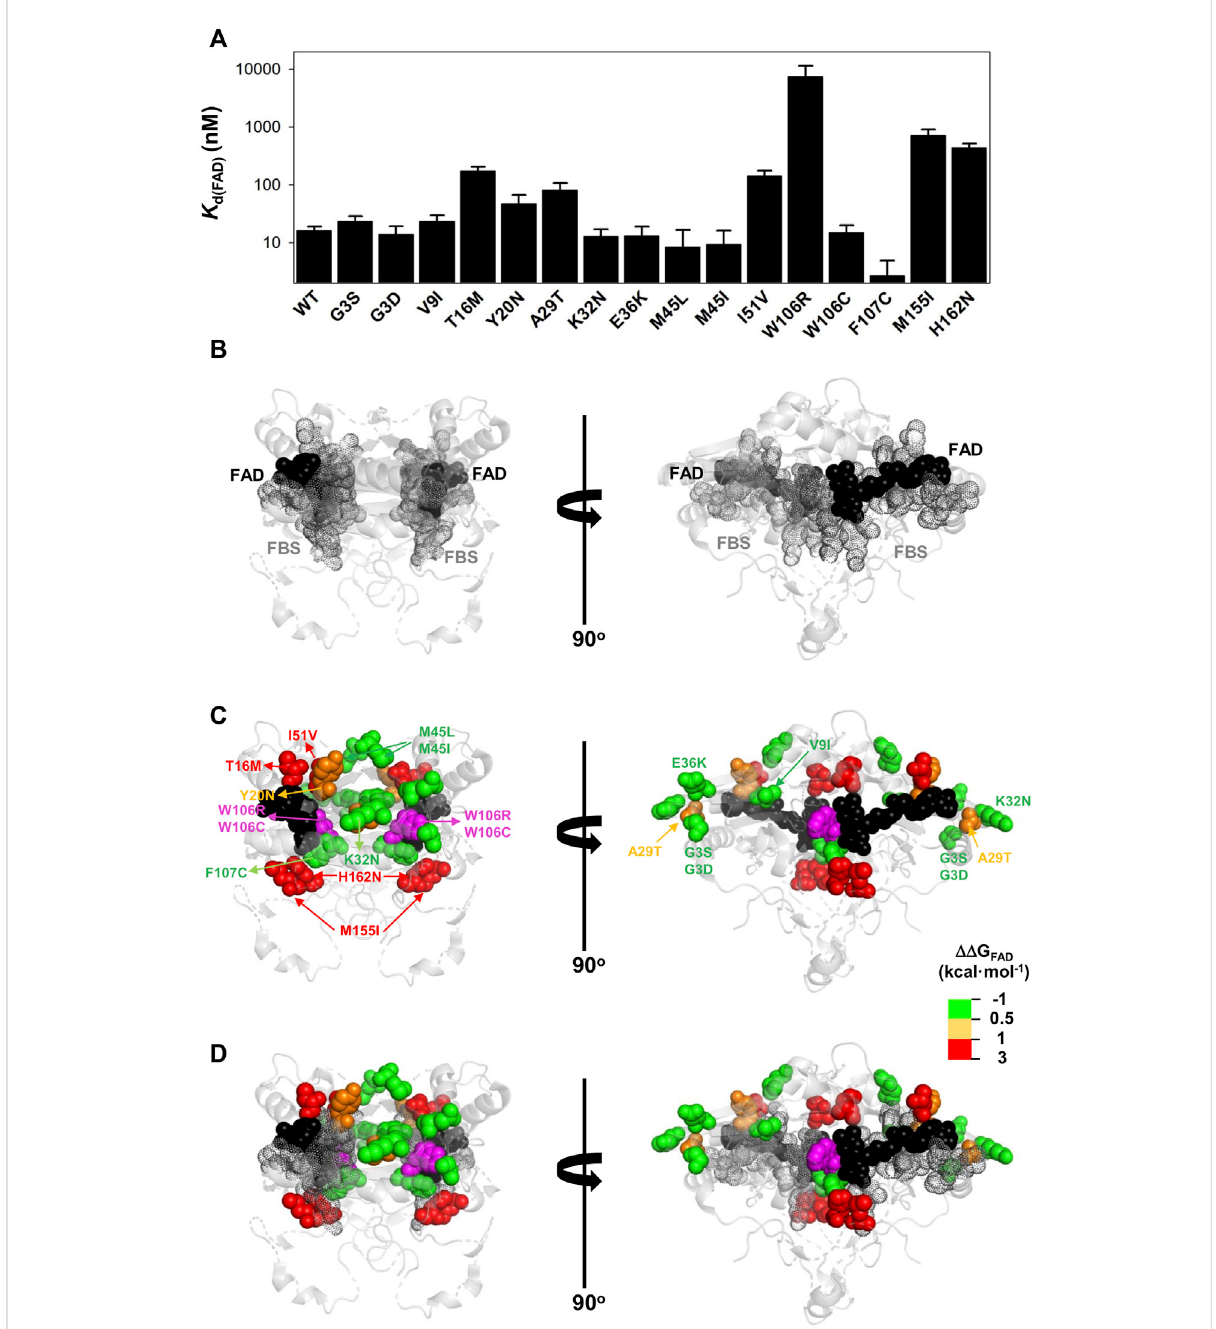
FIGURE 6 Variant effects on the FAD binding af fi nity. (A) FAD binding af fi nity of each variant was determined by titrations of apo-proteins. At least two independent experiments were carried out for each variant and fi tted using a single-type-of-independent binding sites to obtain K d values (note the logarithmic scaleofthe y -axis).Errorsarethose fi ttings. These K d valueswereusedto calculate thebindingfreeenergydifference( ΔΔ G FAD )between a given variant and the WT protein (note that a positive value indicates lower af fi nity). (B – D) Structural location of the FAD (black spheres) and theFBS(greydots) (B) andmutatedresidues(colourscale accordingtotheirdestabilizingeffectonFADbinding) (C) .TheresidueW106ishighlighted in magenta due to the widely different effects of the W106R/W106C substitutions. (D) shows an overlay of (B,C) . Note that two views rotated 90 ° are shown. The structural model used for display was PDB code 2F1O (Asher et al.,